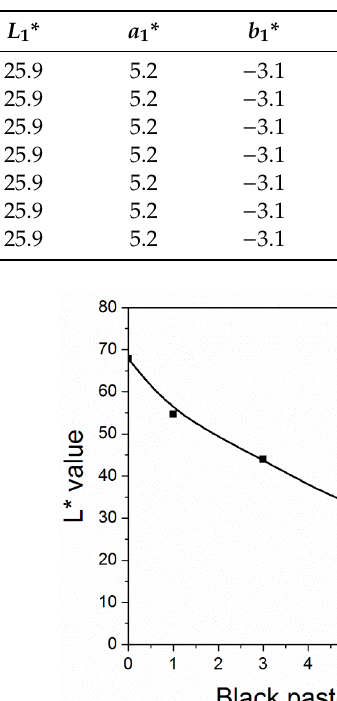
Figure 2. Effect of black paste content on the L * value of the coatings.